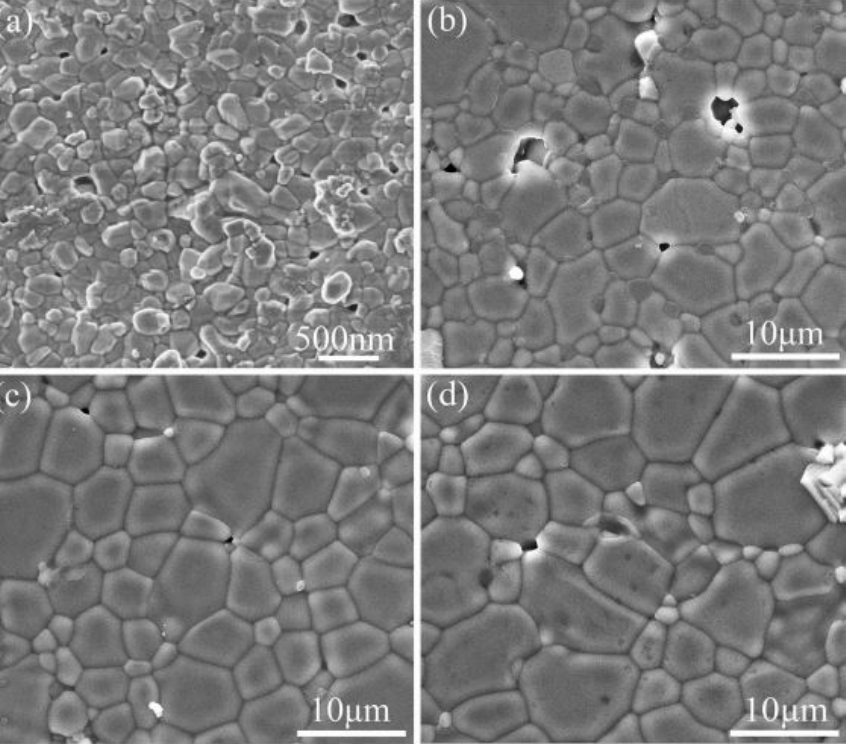
Figure 9. SEM images of ( a ) CCTO powders and CCTO samples sintered by SPS at ( b ) 800 °C, ( c ) 850 °C, ( d ) 900 °C [20].